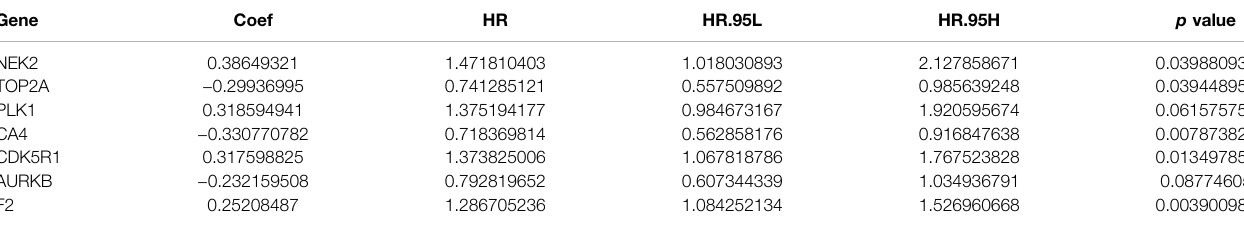
TABLE 4 | Risk model factors of LUAD patients were shown via the multivariate Cox regression analysis.